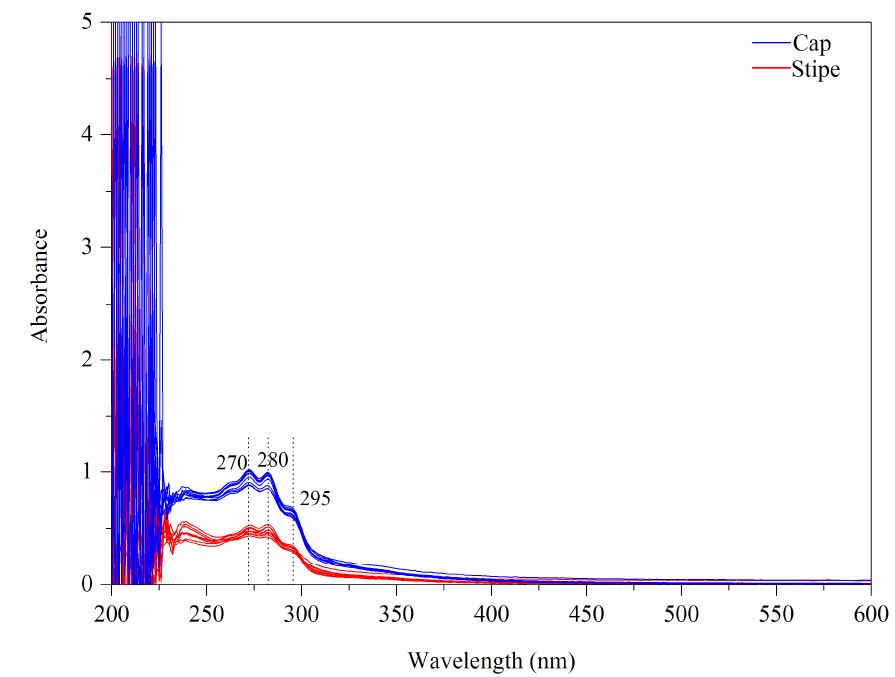
Figure 2. UV-Vis fingerprints of mushroom samples.